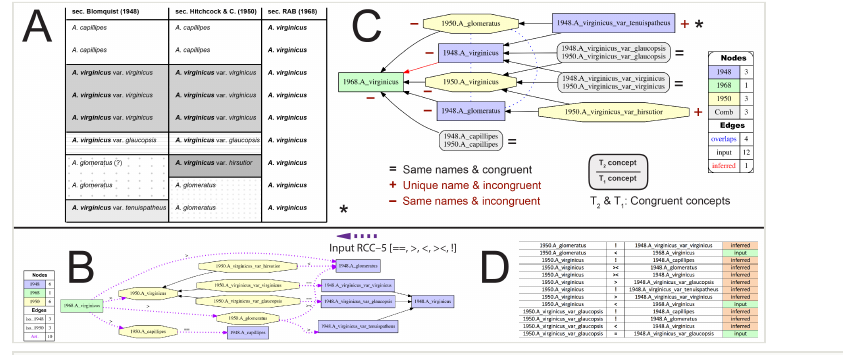
Figure 5. Euler/X toolkit products. (A) Part of the complex " Andropogon use case", with 1948/1950/1968 input sec. Weakley (2015) (see also Fig. 1). (B) Euler/X visualization of input constraints. Each concept taxonomy is uniquely colored. Ten RCC–5 articulations are provided. (C) Euler/X alignment visualization, showing congruent (grey, rounded) and incongruent (colored) alignment regions. Arrows represent proper inclusion; blue dashed lines show overlap. (D) Subset of 48 inferred, Maximally Informative Relations (MIR). The "*" represents the 1948. Androgon _var_ tenuispatheus concept lineage throughout (A) and